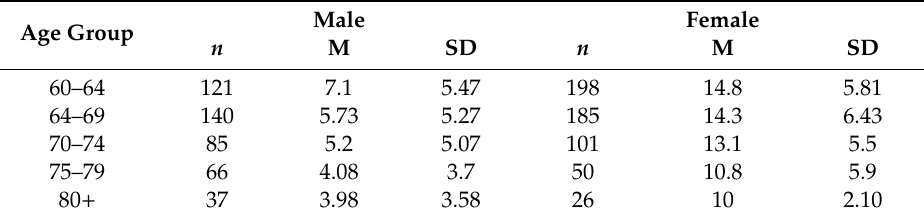
Table 9. Sit and reach based on age group and gender before log transformation. Unit: